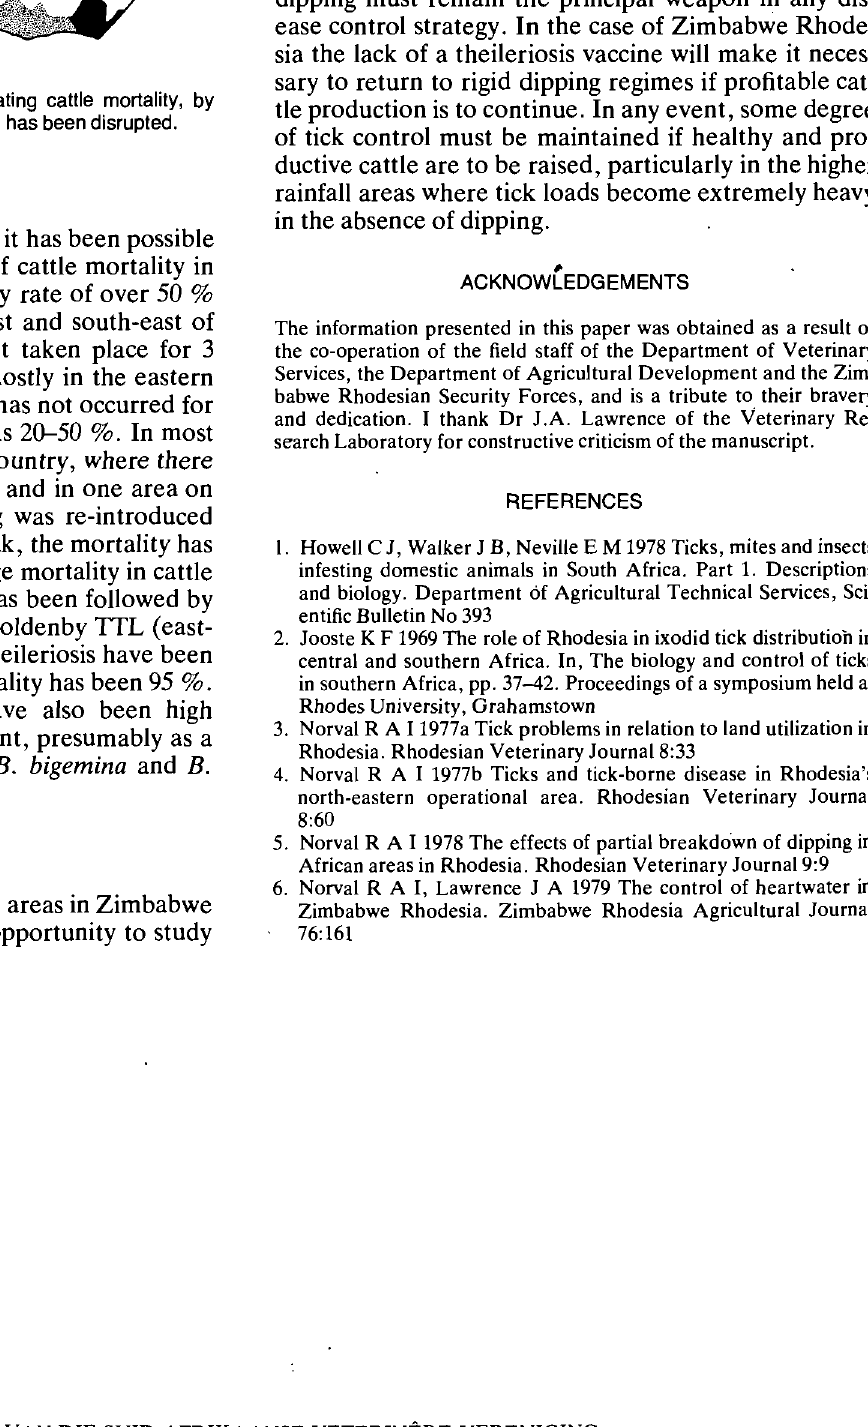
Fig. 7. Map of Zimbabwe Rhodesia indicating cattle mortality, by August 1979, in areas where dipping has been